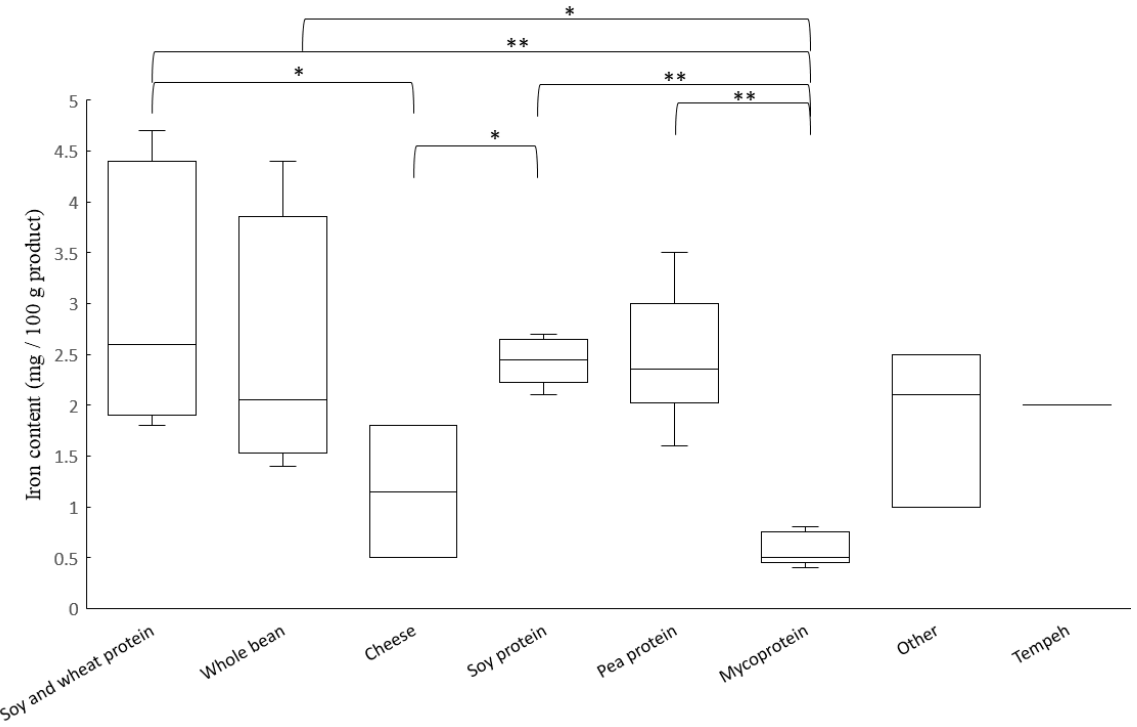
Figure 1. Boxplot of iron content in analyzed meat substitutes, sorted and analyzed according to main source of protein. Line inside the box shows the median value, top of each box is the 75th percentile, and bottom of each box is 25th percentile. Whiskers are maximum and minimum values; small circles are outliers. A p -value < 0.05 is illustrated with * and a p -value < 0.01 with **.